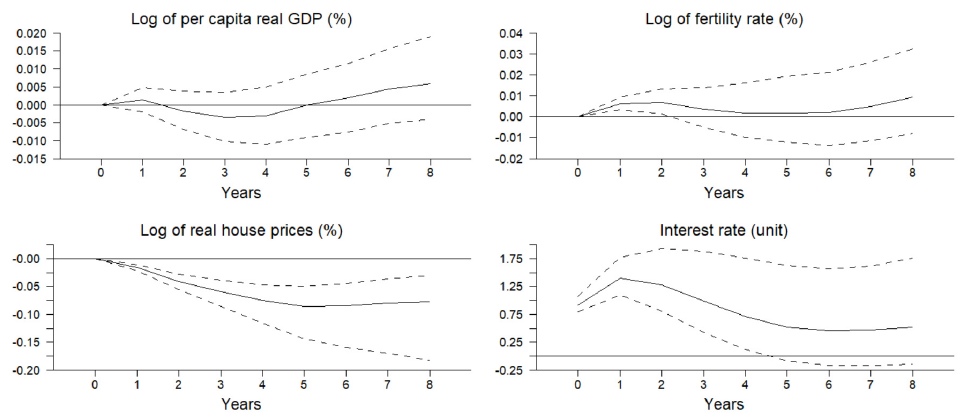
Figure 5. Responses to an interest rate shock in the baseline SVAR.